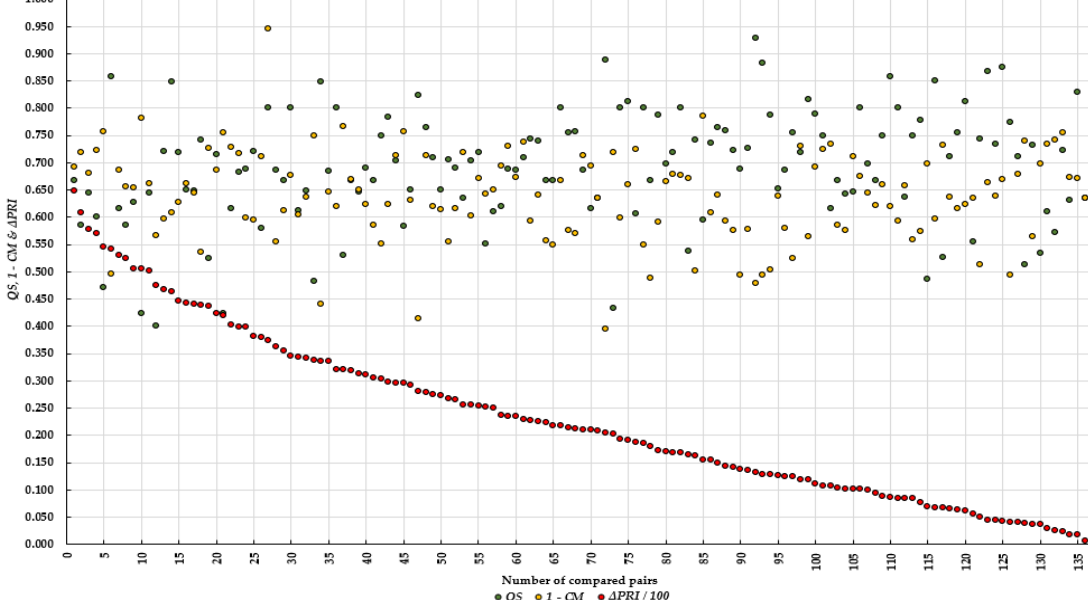
Figure 2. A pairwise comparison between the values of QS , 1 − CM and Δ PRI for the third case study following their numerical ordering based on the values of Δ PRI . Legend: QS , 1 − CM and Δ PRI are defined in Section 2.2.3.